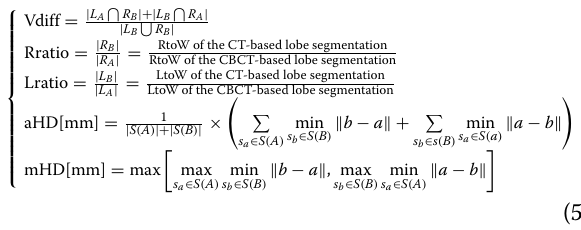
defined) planes that are used to separate the LPTs.